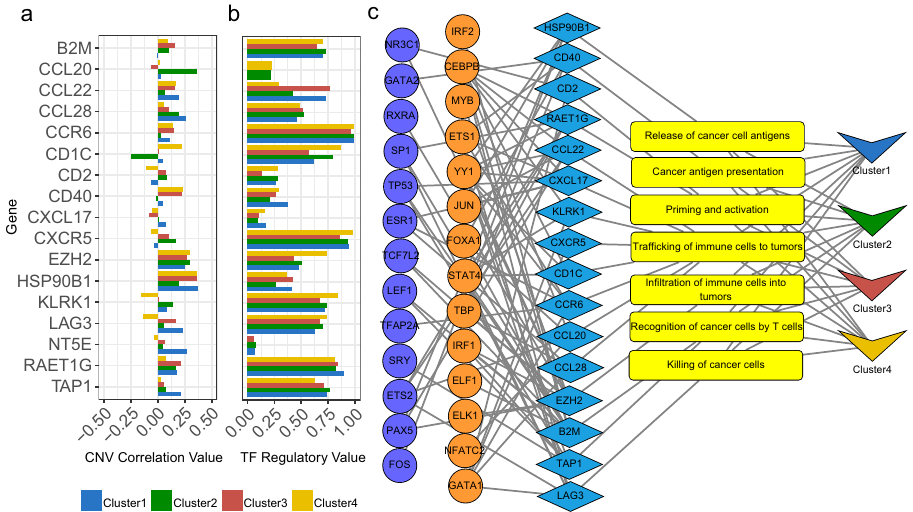
Fig. 6 The CNV correlation and regulatory relationship results of four clusters. a The extent to which IR genes are in fl uenced by CNV in the L0Reg framework. b IR genes are regulated by the TFs identi fi ed by the L0Reg framework. c The regulatory network drawn based on the results of the L0Reg framework. Red circles are negative regulated TFs, blue circles denote positive regulated TFs, blue diamonds are IR genes, yellow rectangles are stages of immune cycle, and V-shaped triangles represent